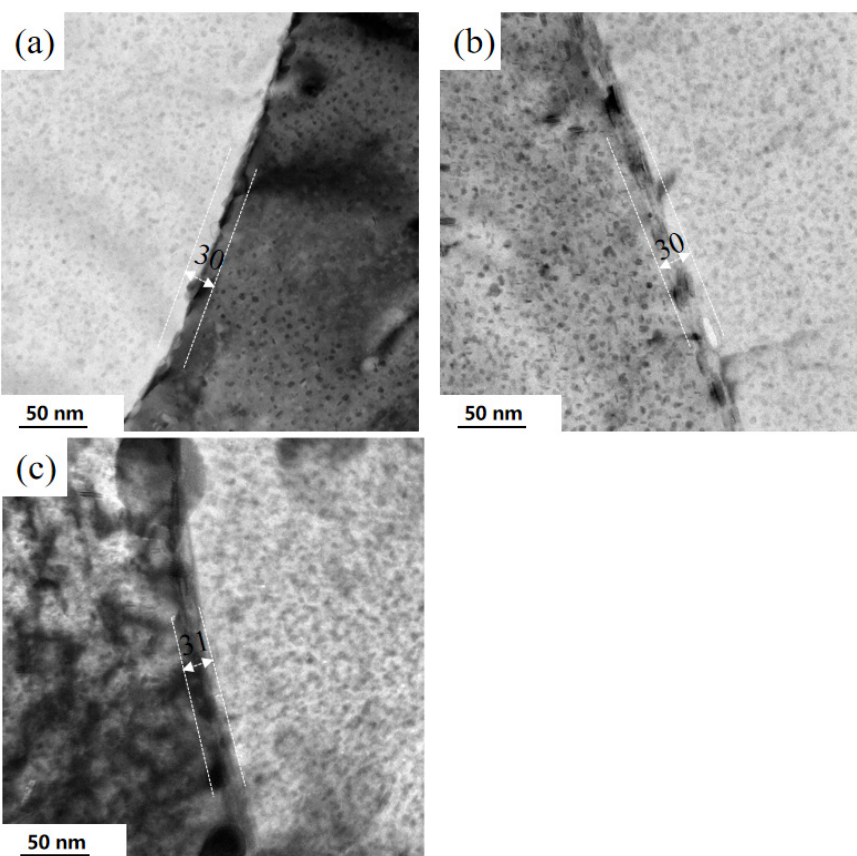
Figure 12. The TEM images of grain boundary precipitates of 7B04-P al alloy under applied stress of 250 MPa at 140 °C during creep aging: ( a ) 4 h; ( b ) 8 h; ( c ) 12 h.